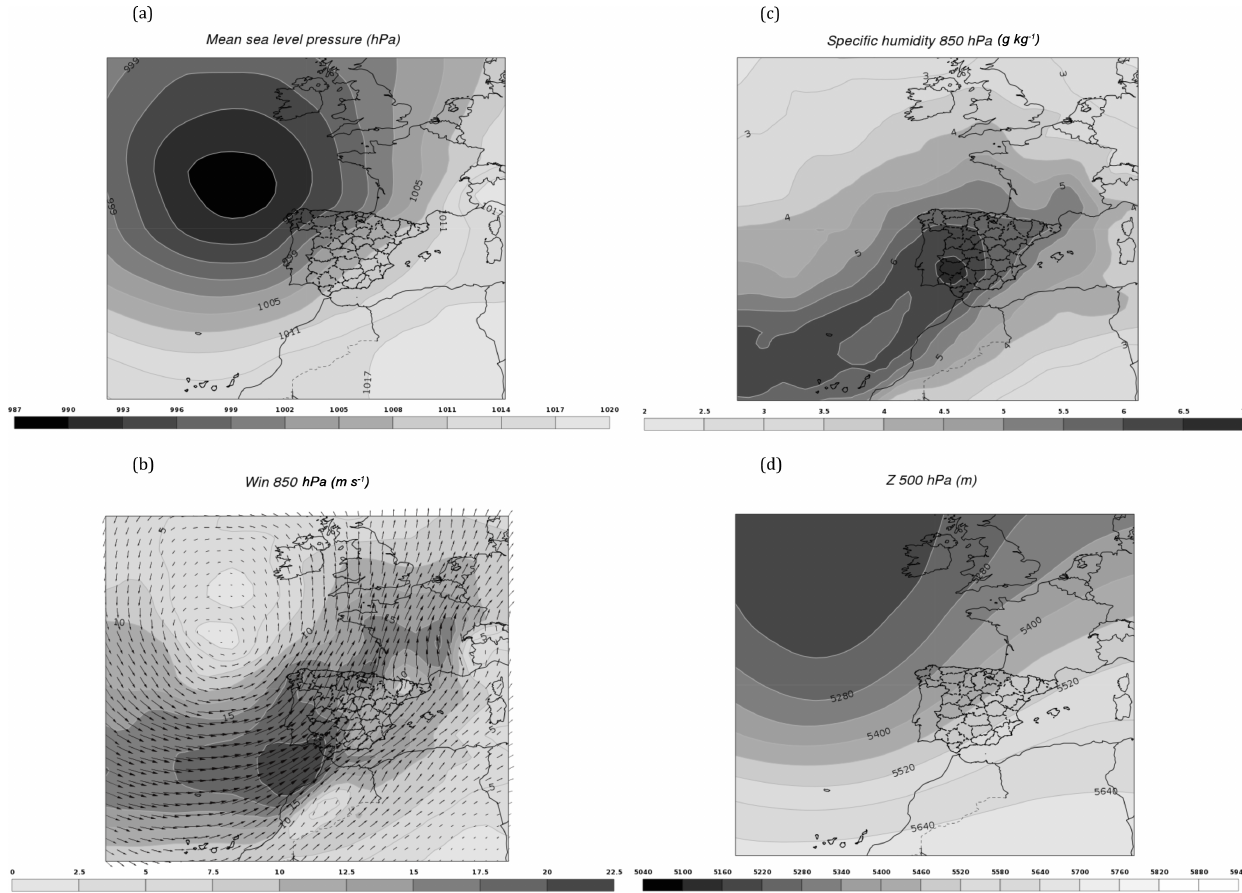
Figure 2. Average fields for the episodes studied (listed in Table 1) at 12:00UTC of (a) mean sea level pressure (hPa); (b) wind (ms − 1 ) and